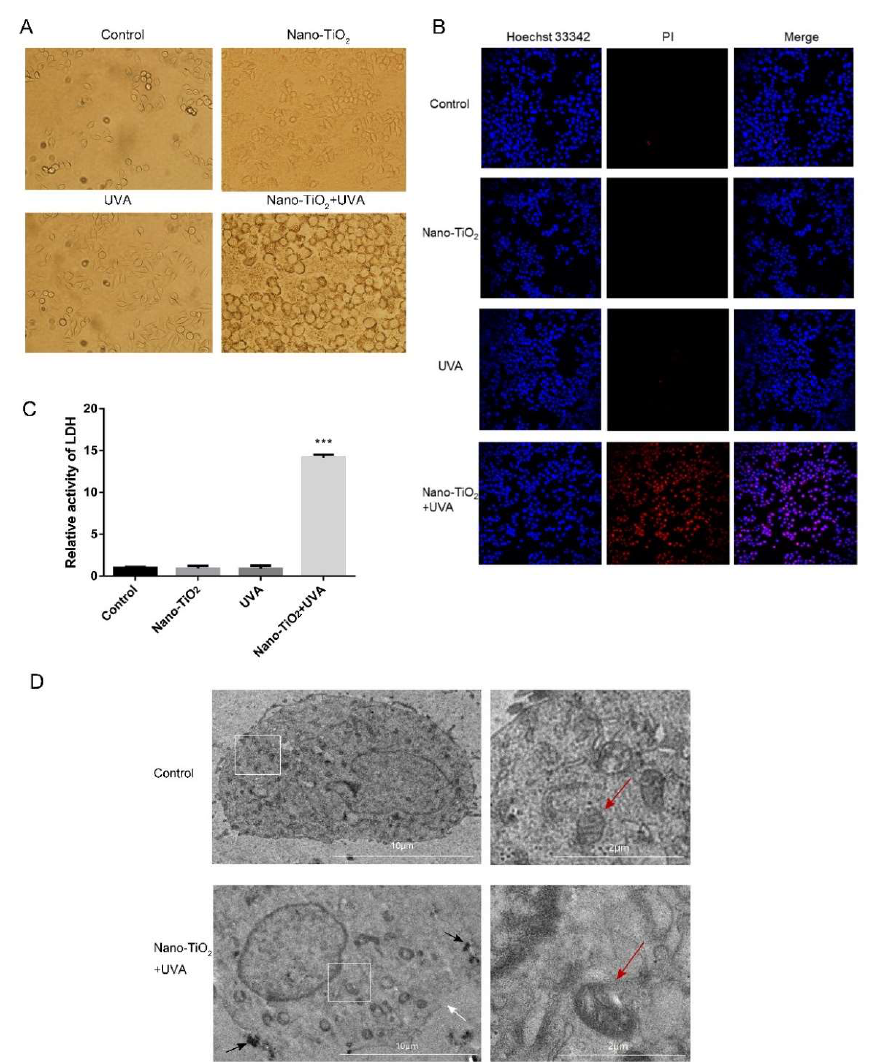
Figure 3. Cell necrosis induced by nano-TiO 2 under UVA irradiation HeLa cells. ( A ) Cell morphology was observed under a light microscope. ( B ) Hoechst 33342 / PI staining to detect the integrity of cell membrane. ( C ) Lactate dehydrogenase (LDH) released by cells was detected. n = 5, *** p < 0.001, compared with control group. ( D ) The ultrastructure of the cells observed by a transmission electron microscope. Black arrow represents nano-TiO 2 in the cell; white arrow represents cell membrane rupture; red arrow represents mitochondria